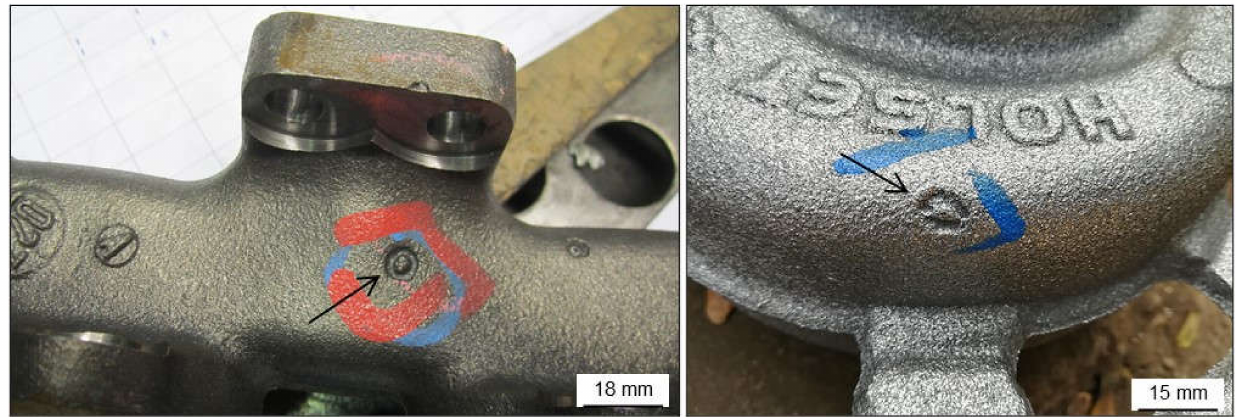
Figure 53. Areas of castings showing fish-eye